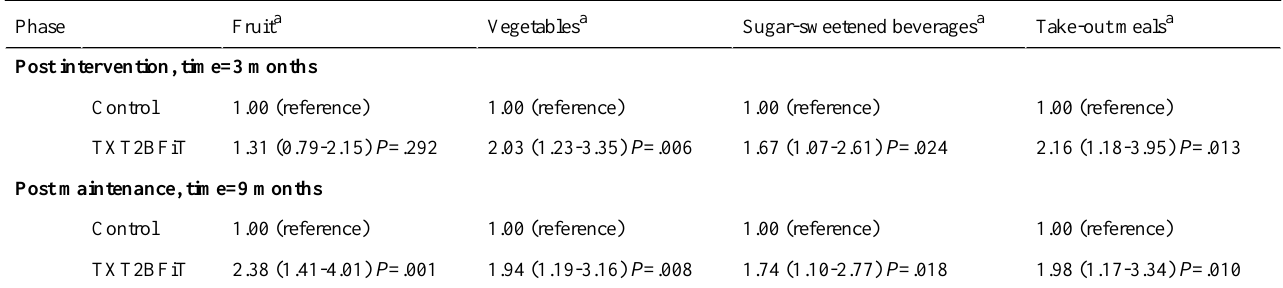
Table 3. Odds ratios (95% confidence intervals) of improved intakes a for TXT2BFiT intervention versus control post-intervention (3 months) and post-maintenance (9 months) adjusted for practice and